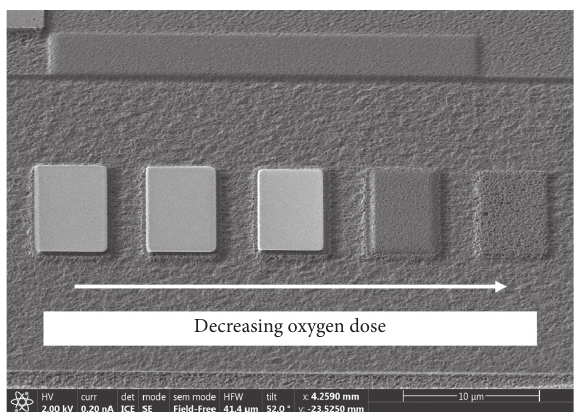
Figure 6: An array of O + implanted regions after the entire region was exposed to XeF the right.